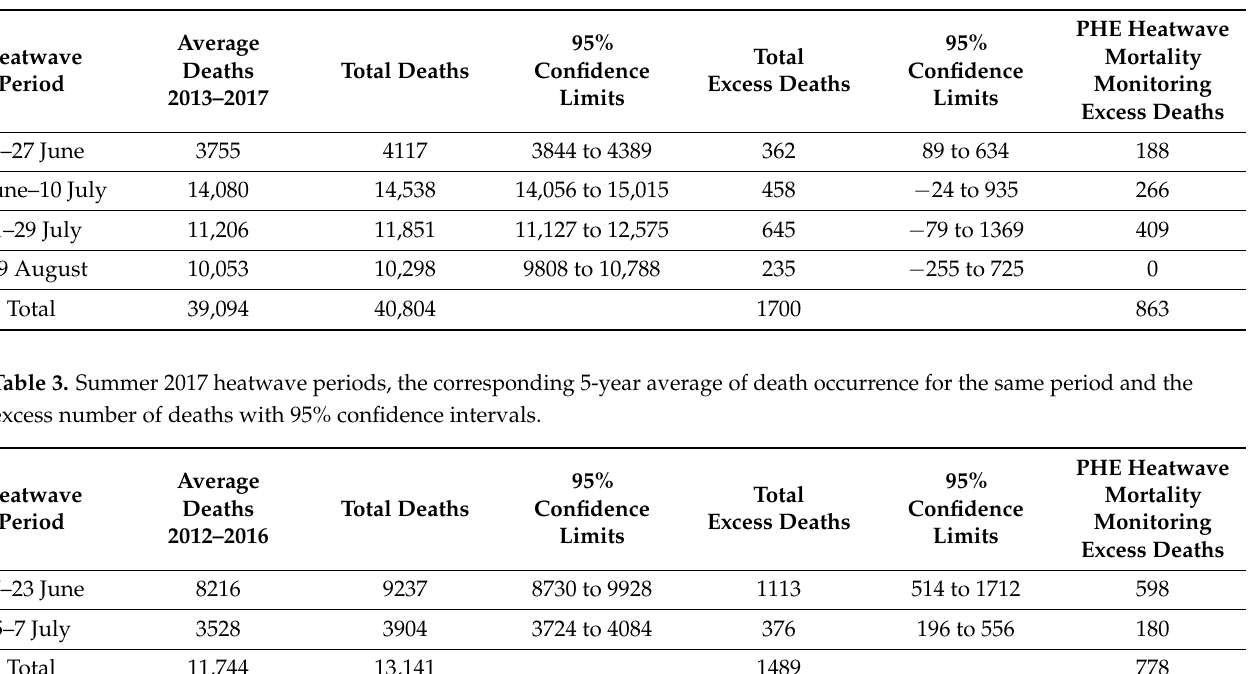
Table 2. Summer 2018 heatwave periods, the corresponding 5-year average of death occurrence for the same period and the excess number of deaths with 95% confidence intervals.